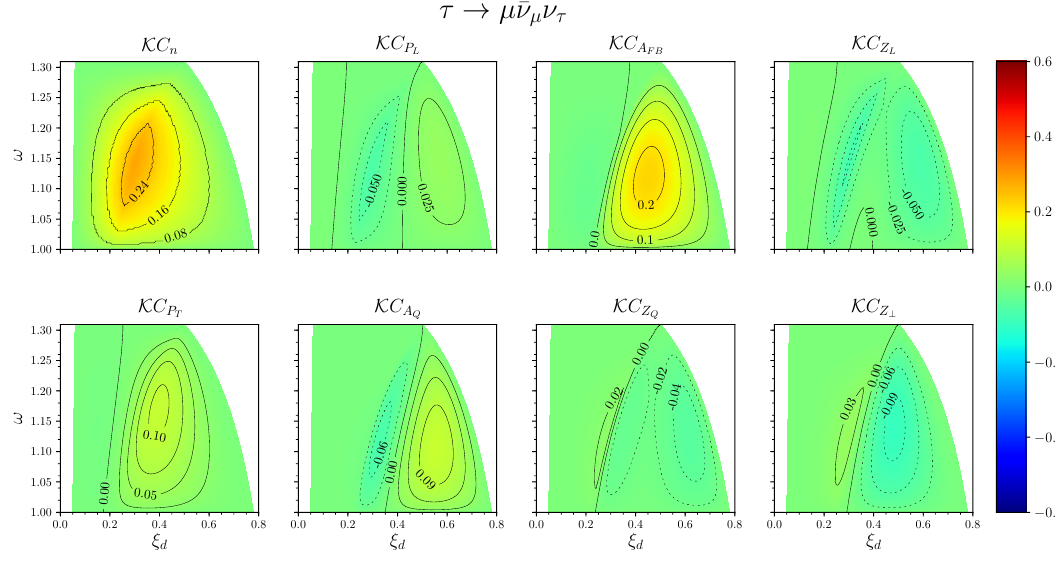
Figure 4 . Same as figure 3 but for the µ ¯ ν µ tau-decay